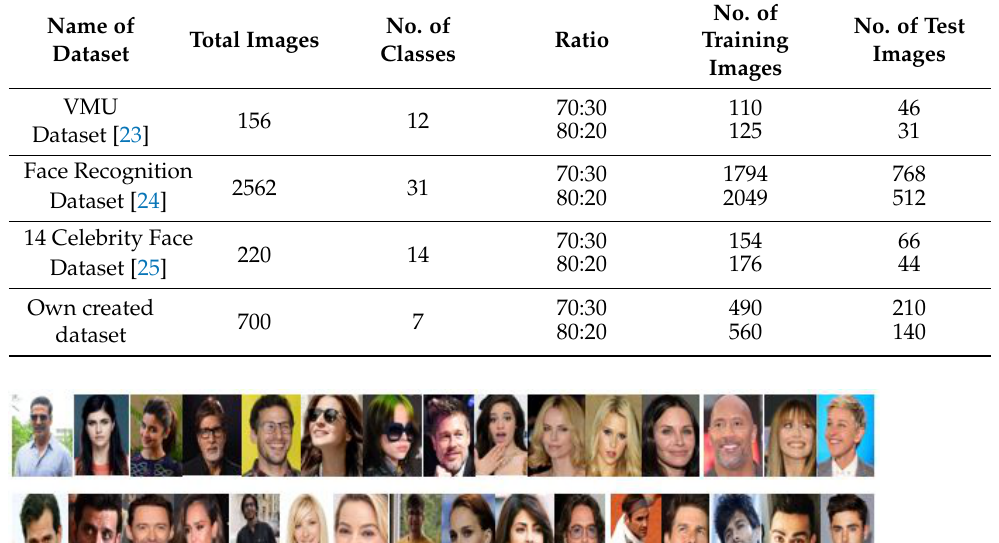
Table 1. Datasets used for evaluation of the proposed research.